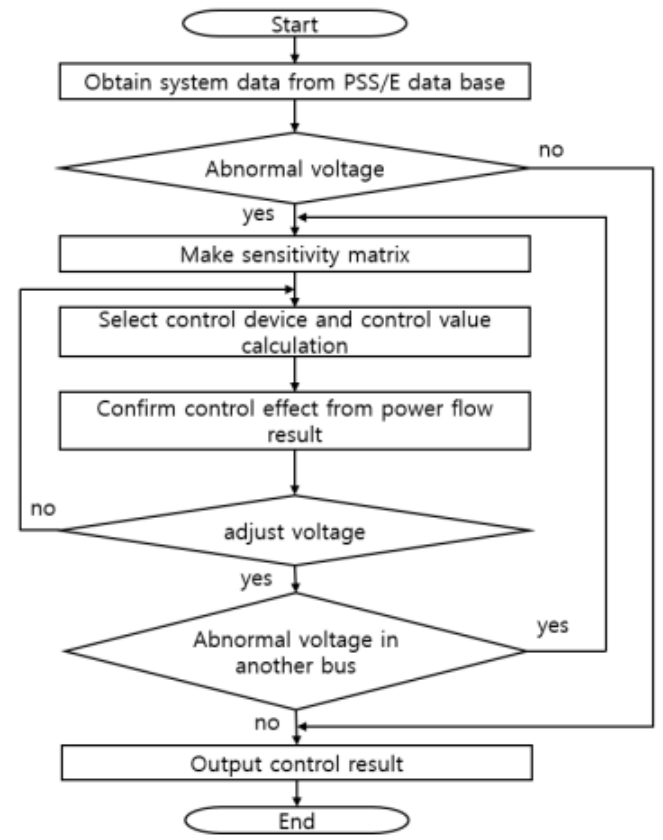
Figure 3. Flowchart of the inference process of the expert